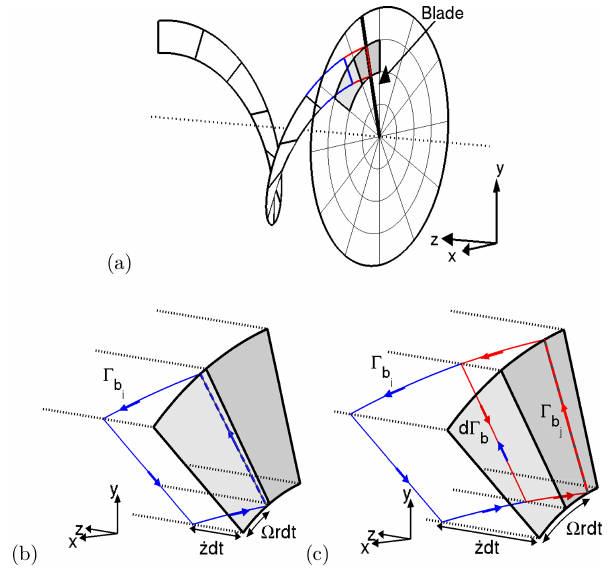
Figure 4. (a) Sketch of vorticity shed from a blade section, when the bound vorticity changes in the tangential direction. (b, c) Close view of the blade section at two successive time instances, showing the definition of d (cid:48) b .